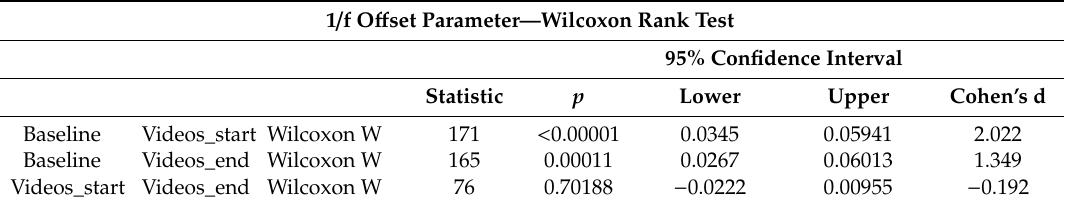
Figure 2. Scatter-plots represent the equal error rates (EERs) for each experimental condition for the offset parameter. Table 1. Statistical analysis for the 1/f offset parameter.